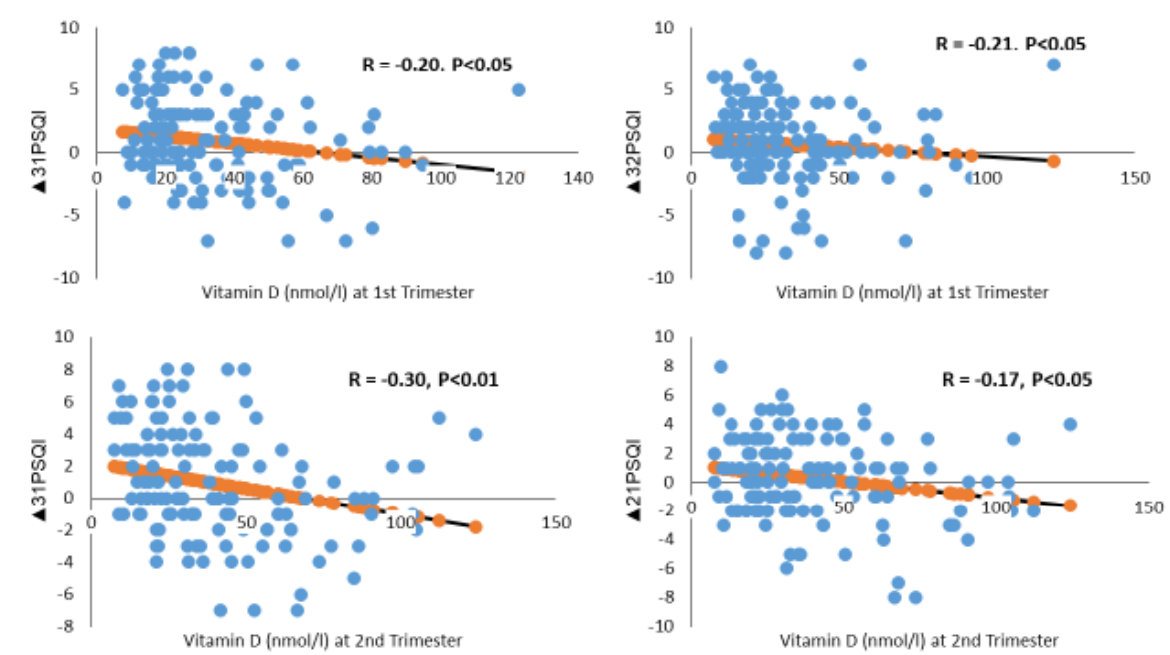
Figure 3. Vitamin D status in relation to changes in Pittsburgh Sleep Quality Index (PSQI) scores across pregnancy. ∆ 31 , ∆ 21 , and ∆ 32 indicate changes in the PSQI score from the 3rd to the 1st, 2nd to 1st, and 3rd to 2nd trimester. Table 4. Vitamin D and changes in sleep index. Table 5. Predictors of poor sleep (total PSQI) changes during